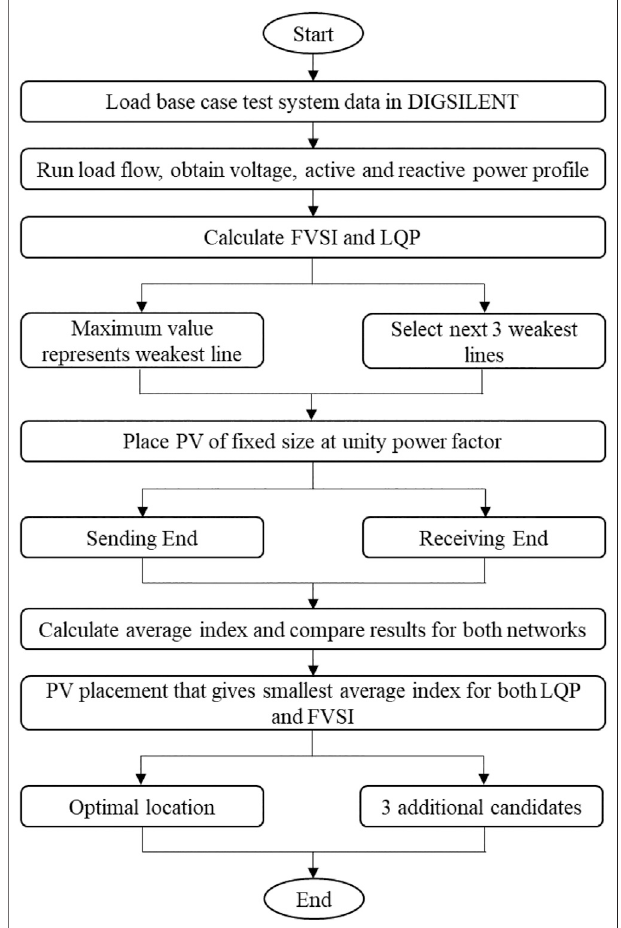
FIGURE 3 | Flow chart for the proposed analytical